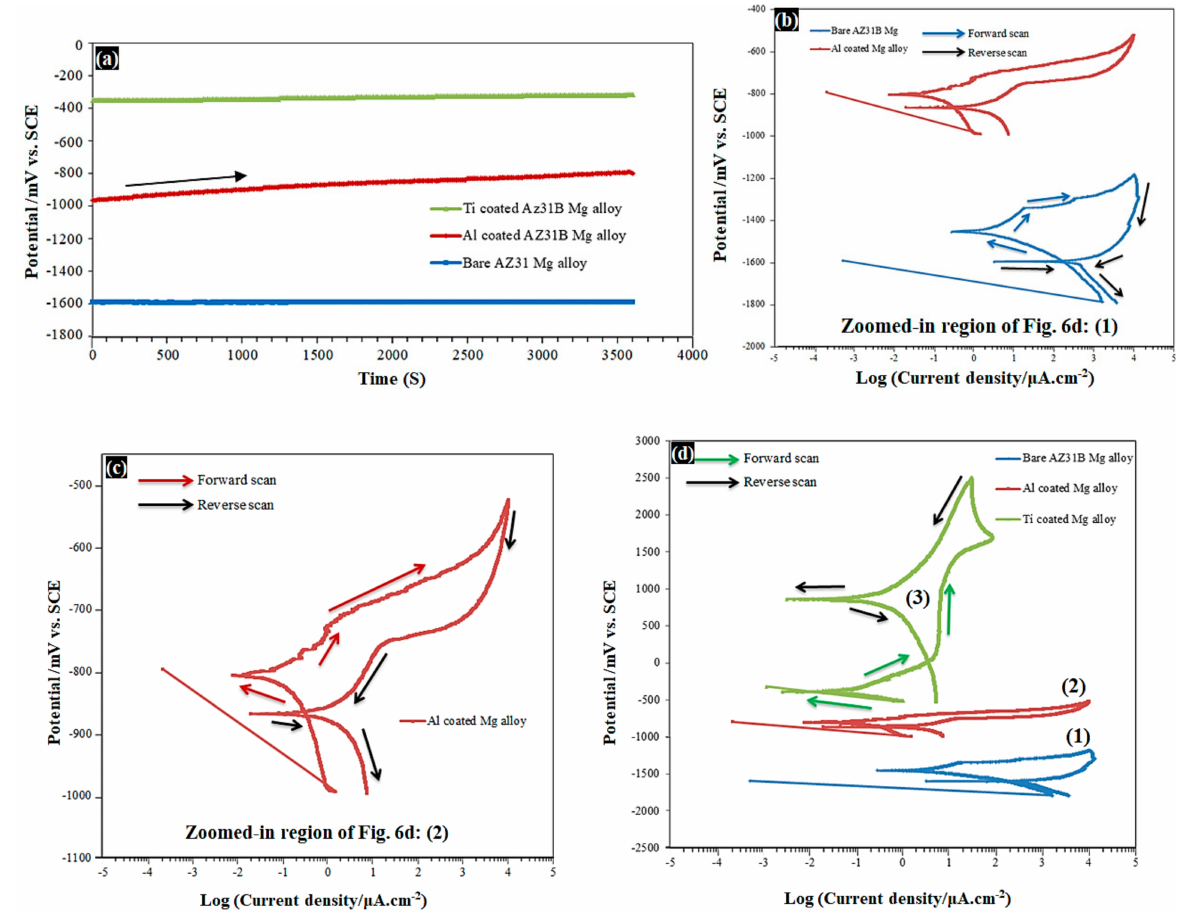
Figure 6. ( a ) Open circuit potential (OCP) for 1h, and ( b – d ) cyclic potentiodynamic polarization (CPP) curves for bare and coated AZ31B Mg alloys in 3.5 wt % NaCl